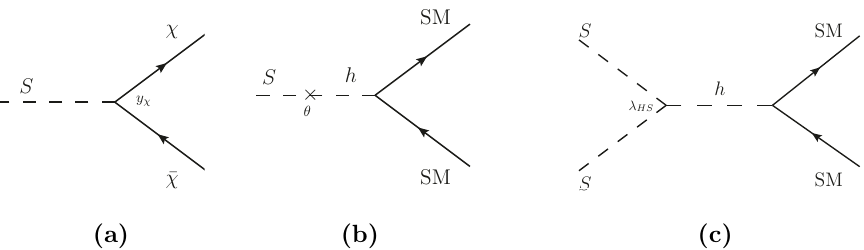
Figure 4. Feynman diagrams for the dominant processes governing the freeze-in of (cid:31) . (a) The main (cid:31) production mode through mediator decay. (b) The mediator decay to SM particles through mixing with the Higgs a(cid:11)ecting both the freeze-out of S and the branching fraction of late time decays. (c) Pair annihilation of S contributing to the freeze-out of S . The relative importance of these processes is to large extent determined by the hierarchy of the highlighted couplings y and (cid:21) HS as well as by the mixing angle (cid:18)